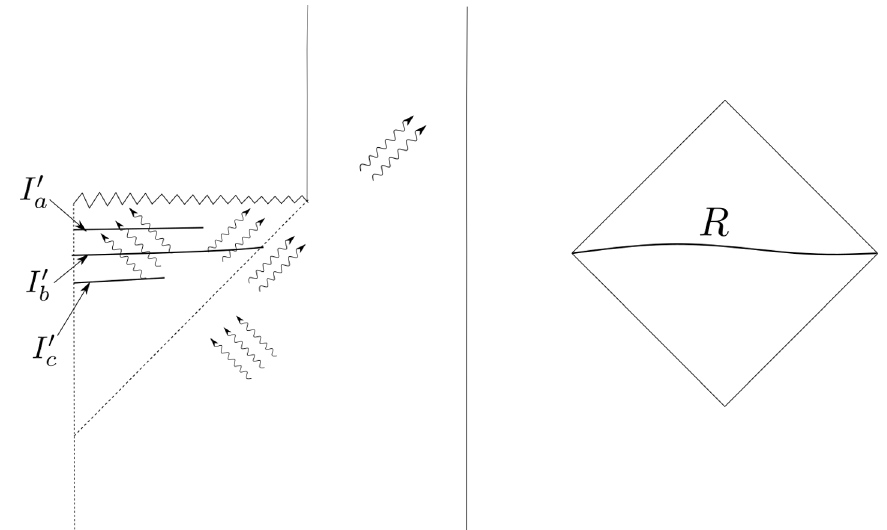
Figure 6 : A small, critically illuminated, isolated AdS black hole, and an auxiliary non- gravitating flat spacetime. The radiation shown includes the incoming radiation that keeps the black mass constant, the outgoing Hawking modes, and their interior partners. The ingoing radiation is maximally mixed and purified by the degrees of freedom in R in an auxiliary